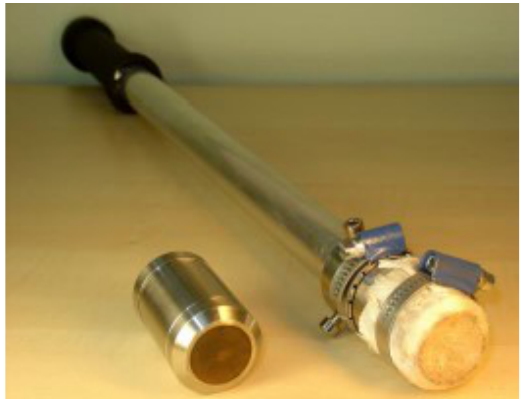
Figure 12. EMAT transducer on the left as it is, and on the right with heat protection, adapted from [31].